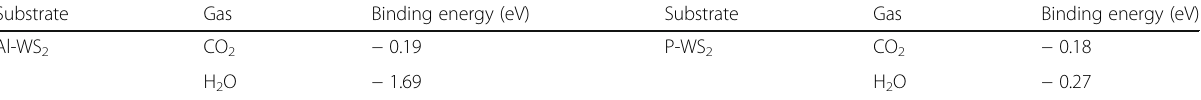
Table 2 Binding energy of Al- or P-doped WS 2 with CO 2 or H 2 O gas adsorption on the energetically favorable site